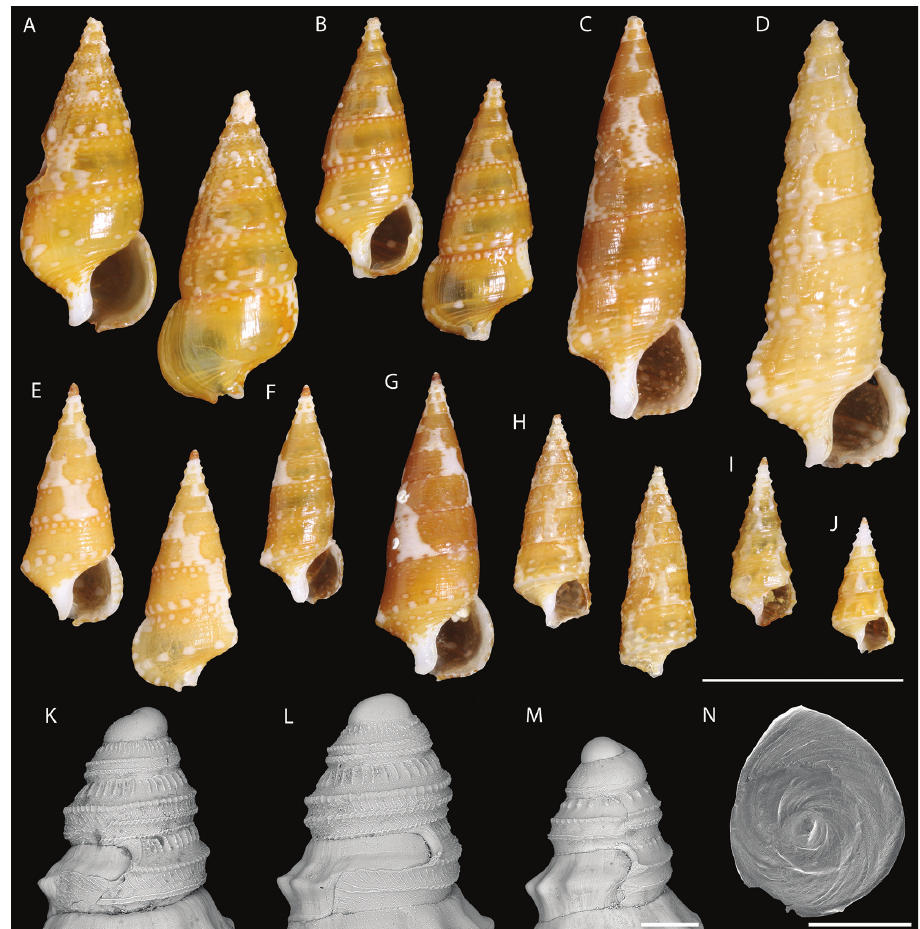
Figure 3. Shell and operculum morphology of Limatium aureum sp. n. ( A–H, K, L, N ) and Limatium sp. ( I, J, M ). Limatium aureum sp. n.: A Holotype, MNHN IM-2013-42460. Austral Islands, Maria B Austral Islands, Pointe Kauira, RAPA 2002 stn. 36 (MNHN IM-2014-6920) C New Caledonia, CO- RAIL 2 stn. DW26 (MNHN IM-2014-6921) D Tonga, between Eua and Tongatapu, BORDAU 2, stn. DW1512 (MNHN IM-2014-6922) E Austral Islands, NW of Tauna Islet, RAPA 2002 stn. 44 (MNHN IM-2014-6923) F New Caledonia, Grand Récif Aboré off Nouméa, MONTROUZIER stn. 1352 (MNHN IM-2014-6924). G Loyalty Islands, LIFOU 2000 stn. 1423 (MNHN IM-2014-6925) H Loyalty Islands, LIFOU 2000 stn. 1418 (MNHN IM-2014-6926) K Protoconch, New Caledonia, Grand Récif Aboré off Nouméa, MONTROUZIER stn. 1352 (MNHN IM-2014-6927) L Protoconch, Austral Islands, SE of Tauna Islet, RAPA 2002 stn. 8 (MNHN IM-2014-6928) N Operculum, Austral Is- lands, Pointe Kauira, RAPA 2002 stn. 36 (MNHN IM-2014-6829) (same as in 3B). Limatium sp.: I Phil- ippines, W of Mindoro, MUSORSTOM 3 stn. DR117 (MNHN IM-2014-6830) J Vanuatu, Santo, W of Tutuba, SANTO 2006 stn. DS103 (MNHN IM-2014-6831) M Protoconch, Vanuatu, Santo, West of Tutuba I., SANTO 2006 stn. DS103 (MNHN IM-2014-6832) (same as in 3J). Scale bars: 5 mm ( A–J ); 100 µm ( K–M ); 500 µm ( N